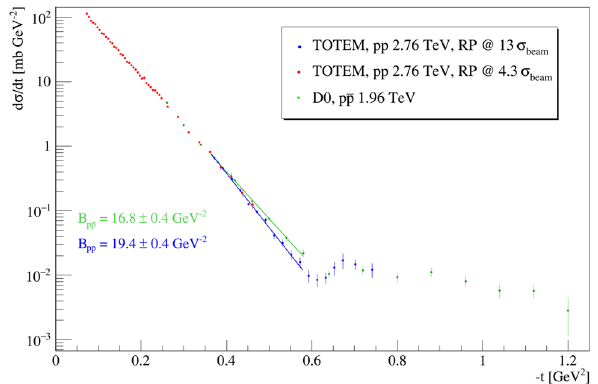
Fig. 11 The exponential fit of the differential cross sections d σ/ d t at √ s = 2 . 76 TeV measured by the TOTEM experiment and the elastic p ¯ p measurement of the D0 experiment at 1.96 TeV in the | t | -range from 0.36 to 0 . 58 GeV 2 . The pp differential cross section shows a steepening before the dip, and the slope parameters in this range quantify another key parameter to claim the significant deviation of pp and p ¯ p